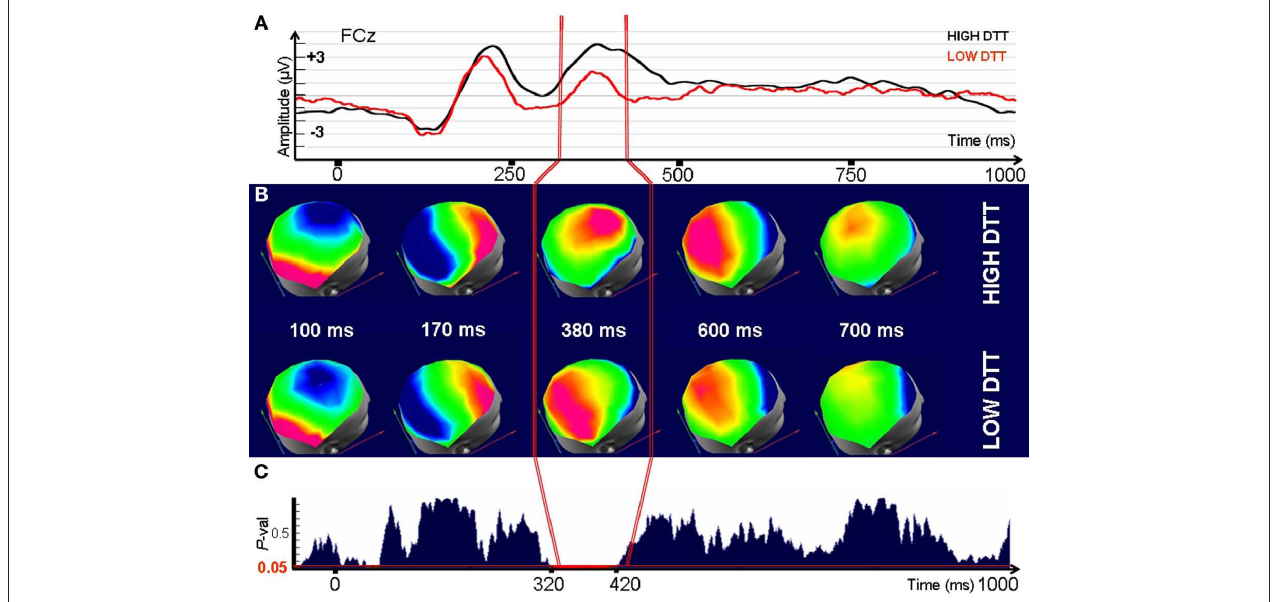
performed on the maps. Threshold for significance ( P < 0.05) is indicated by the red line. Note that the maps (ERP topography) significantly differ between groups in the interval 320–420 ms indicating that the underlying generators are necessarily different. Consequently, High and Low-DTT individuals differ in the neural generators used to cope with disappointing outcomes in the specified